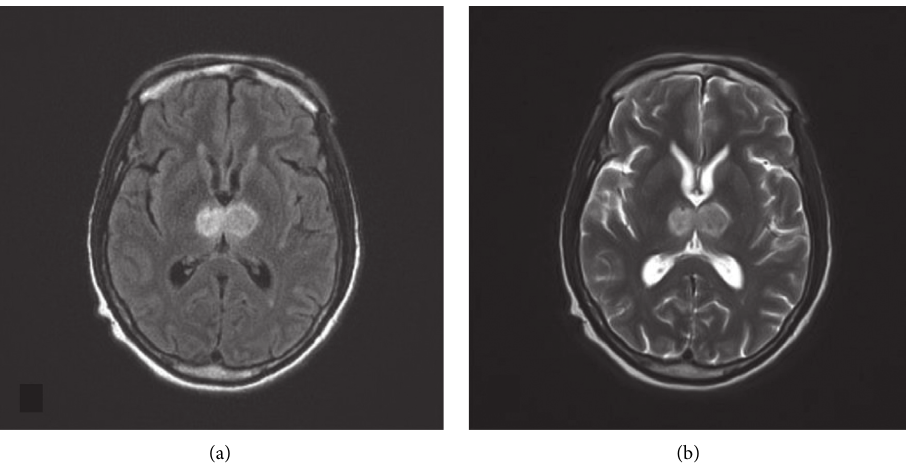
Figure 3: Axial flair (a) and axial T2 (b) MR images obtained one week after the CT demonstrated increased signal bilaterally in the thalamic nuclei.